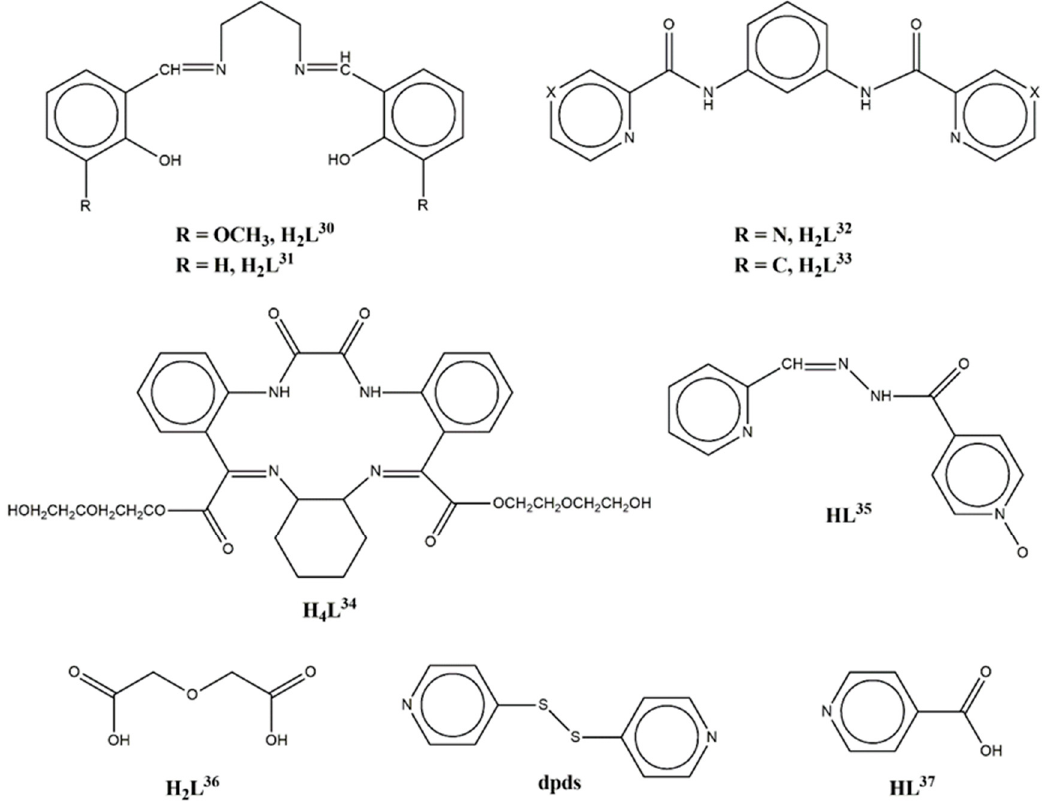
Figure 23. Part of the 2D layer structure of 179 . Color code: Eu large octant, Ni small octant, N light grey, O dark grey, C open small, S open large